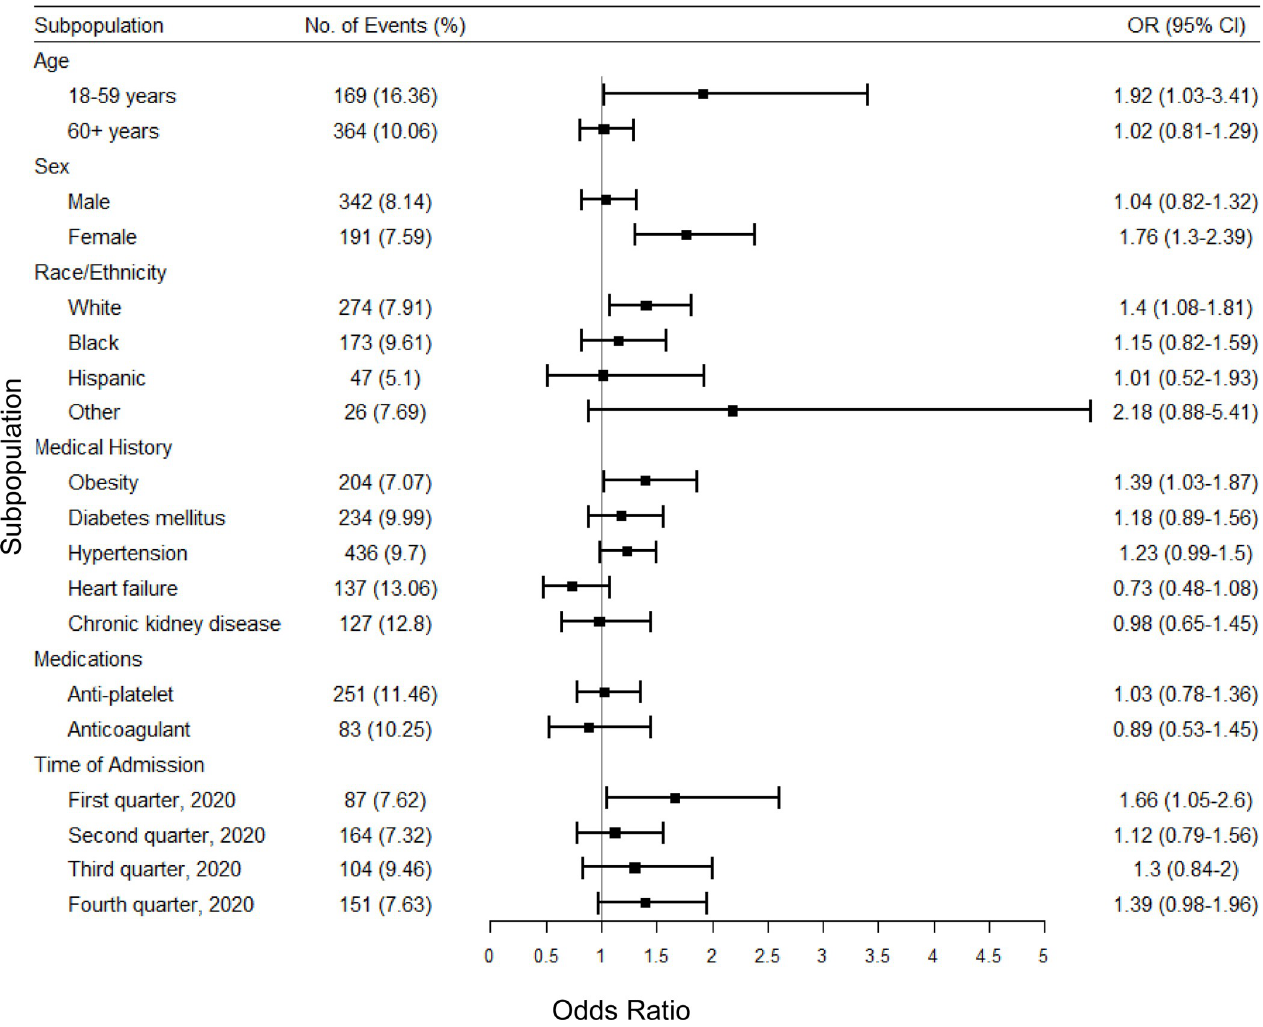
Fig 3. Multivariate analysis of associations between smoking and major adverse cardiac events (MACE) in subpopulations among the propensity- matched study population of the AHA COVID-19 CVD Registry from December 2020 to March 2021. Major adverse cardiac events (MACE) is defined as the hospitalization, intubated, or placed on mechanical ventilation. Obesity is defined as BMI > = 30 kg/m 2 . OR, Odds ratio; CI, Confidence